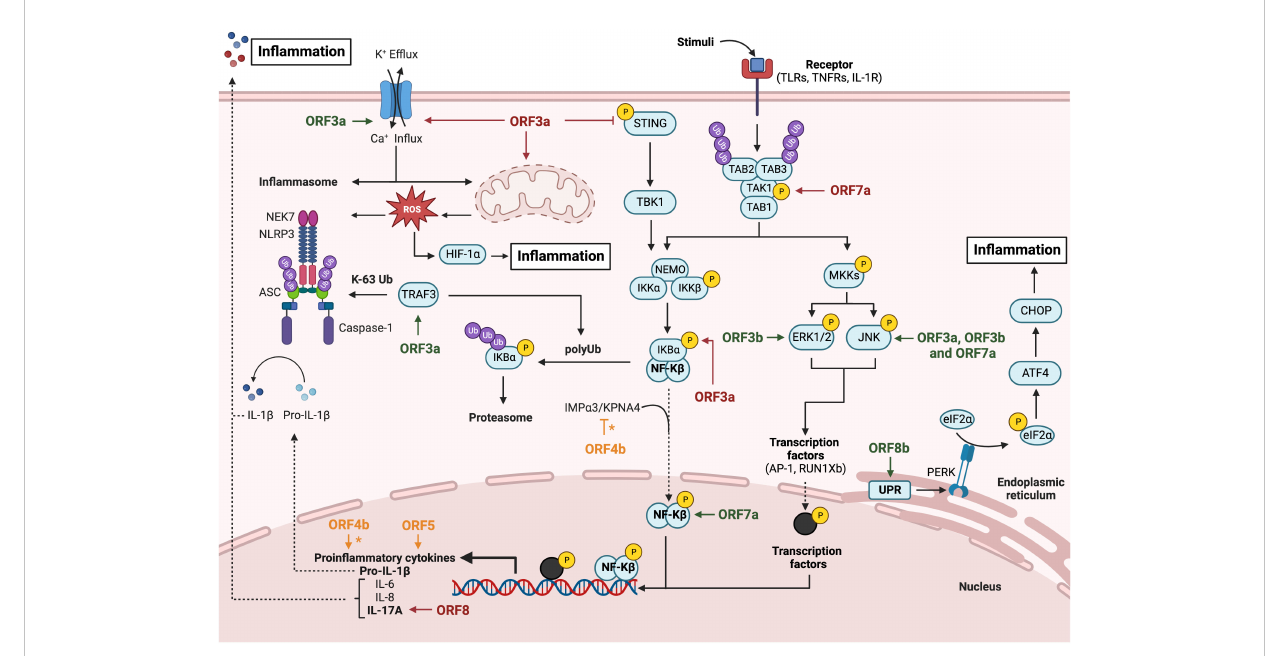
FIGURE 3 Modulation of in fl ammatory response pathway by HCoVs accessory proteins. Diagram representing the activation of the NLRP3 in fl ammasome pathway, the canonical NF-K b pathway and the canonical MAPKs pathway. The in fl ammatory inductors HIF-1 a and CHOP activation are also represented via mitochondrial dysregulation and unfolded proteins response, respectively. SARS-CoV accessory proteins are represented in green, MERS-CoV in orange and SARS-CoV-2 in red. The asterisk (*) indicates inconclusive results. Figure created with